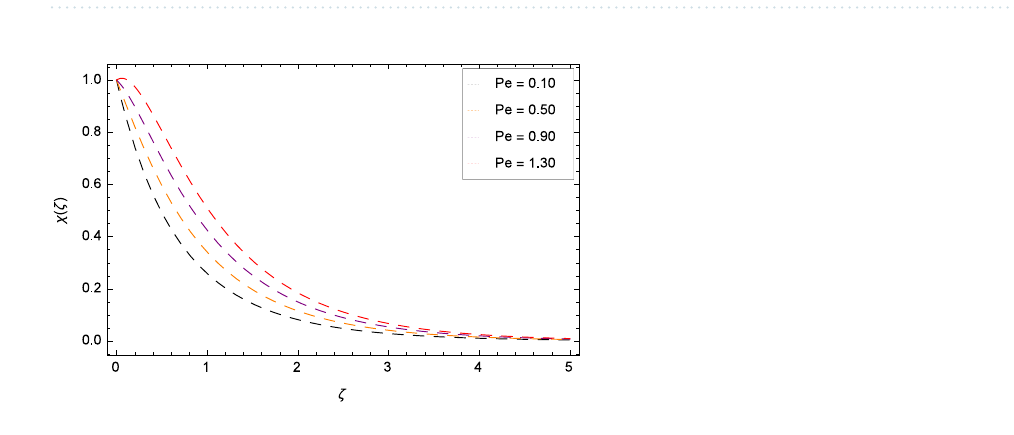
Figure 21. Pattern of graph curves on account of Pe .